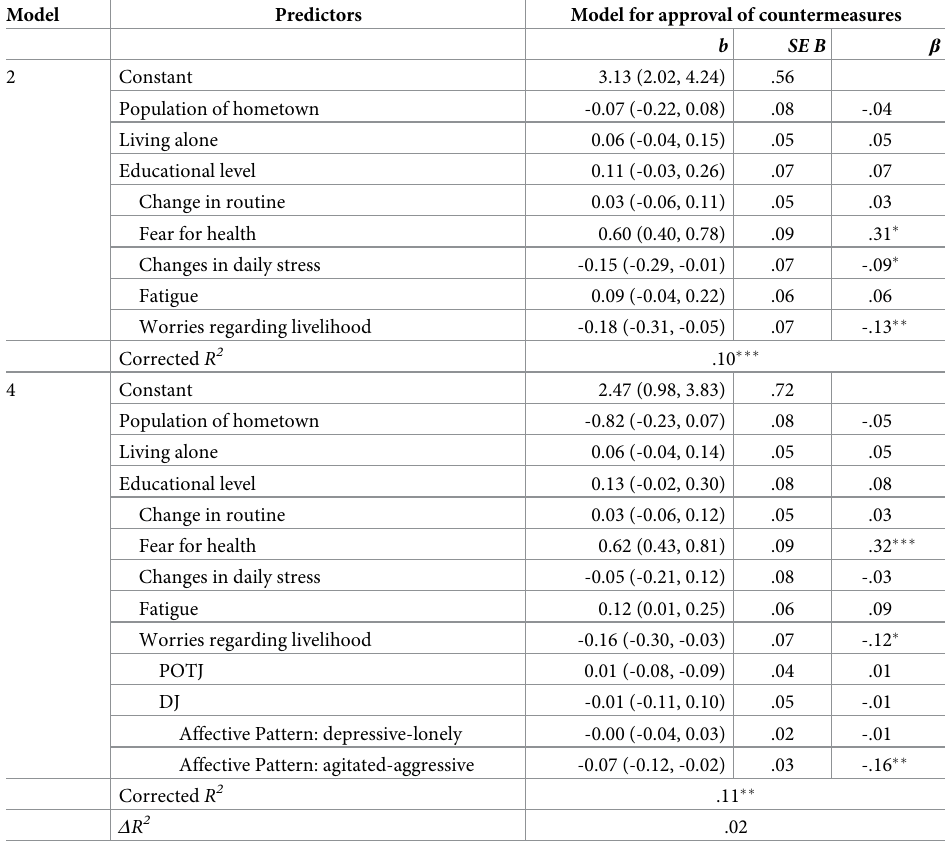
Table 5. Linear model of predictors of approval of